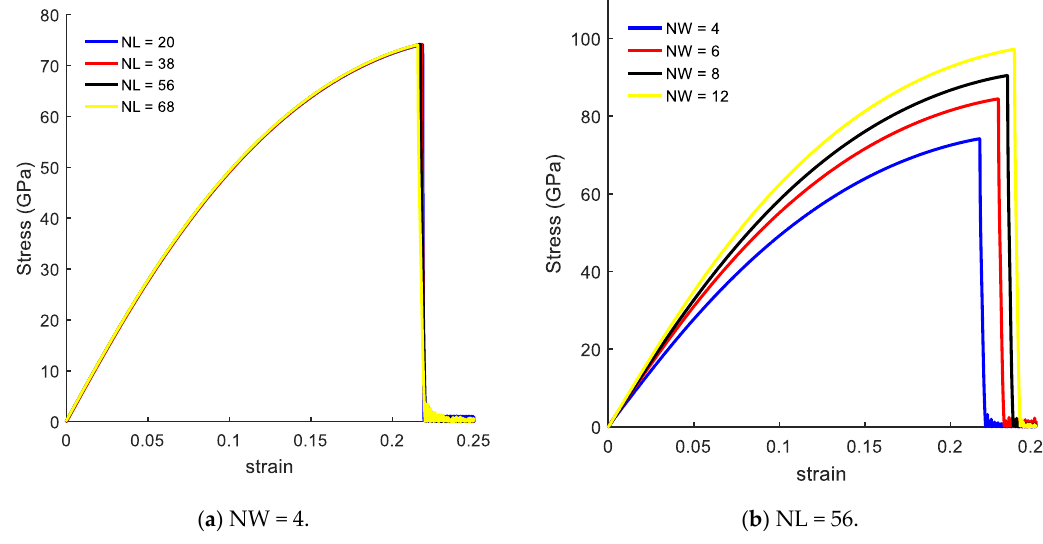
Figure 4. Size effects on the mechanical response of CGNR (2H). Figure 4. Size e ff ects on the mechanical response of CGNR